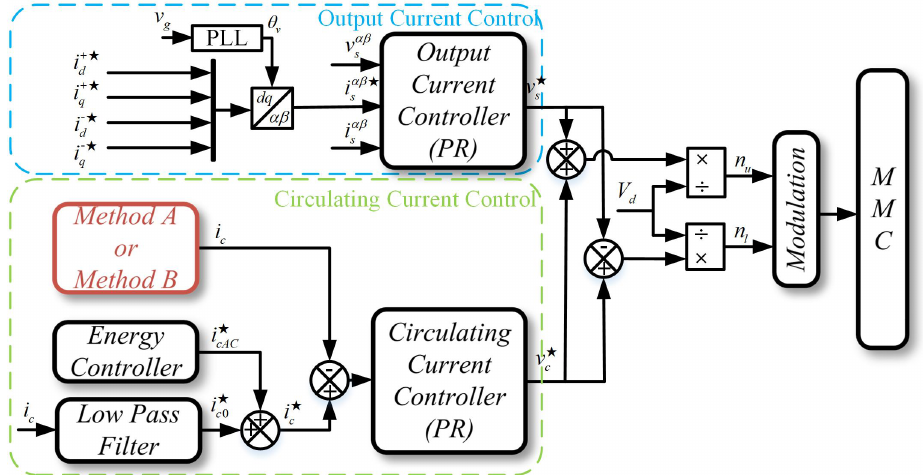
Figure 7. The structure of the proposed MMC